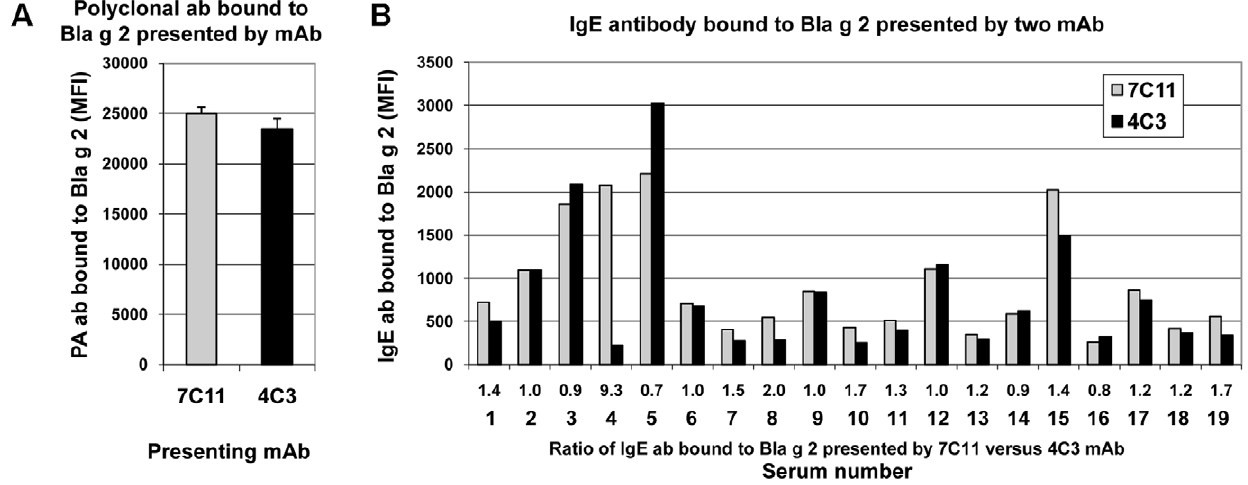
Figure 2. Antibody binding to rBla g 2 presented by mAb 7C11 or 4C3 using multiplex array. A) Anti-Bla g 2 polyclonal antibody bound to rBla g 2 (mean 6 standard deviation, n=5 experiments, p=0.059). B) IgE from sera of cockroach allergic patients bound to rBla g 2. The allergen was presented by either mAb 7C11 (gray) or 4C3 (black). The first and second row of numbers under the X-axis are ratio of IgE bound to Bla g 2 presented by mAb 7C11 versus mAb 4C3 (100%) and serum number, respectively. MFI are Median Fluorescence Intensity Units.